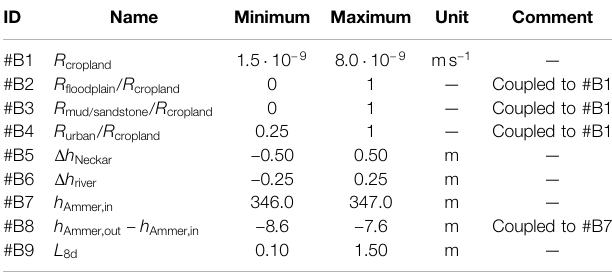
TABLE 2 | Prior ranges of parameters describing boundary conditions of the model.